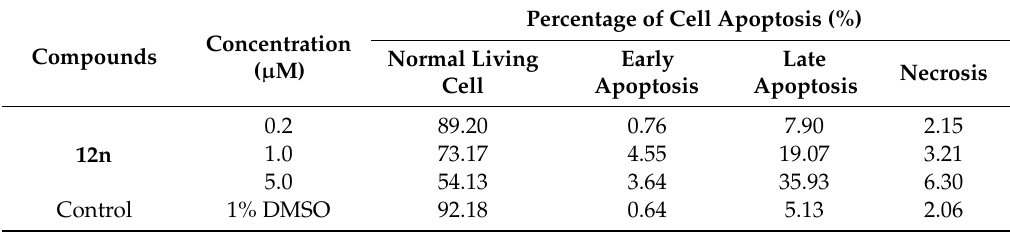
Figure 4. Compound 12n induced apoptosis in PC-3 cells after 48 h through treatment with 12n at different concentrations (0.2, 1.0, and 5.0 μ M). Table 4. The percentage of cell apoptosis of PC3 cells after 48 h through treatment with 12n at different concentrations (0.2, 1.0, and 5.0 µ M).